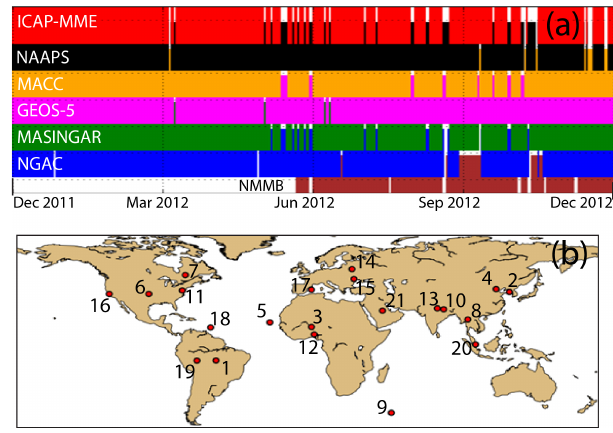
Figure 1. (a) Timeline of available data within this paper’s study period. (b) Location of AERONET sites used for verification. Labels are listed in Table 1.